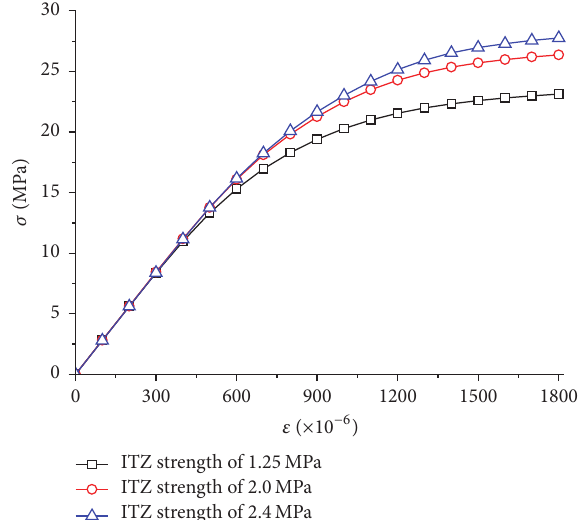
Figure 11: The compressive stress-strain curve of RAC specimen of 100mm × 100 mm with different tensile strengths of ITZ.